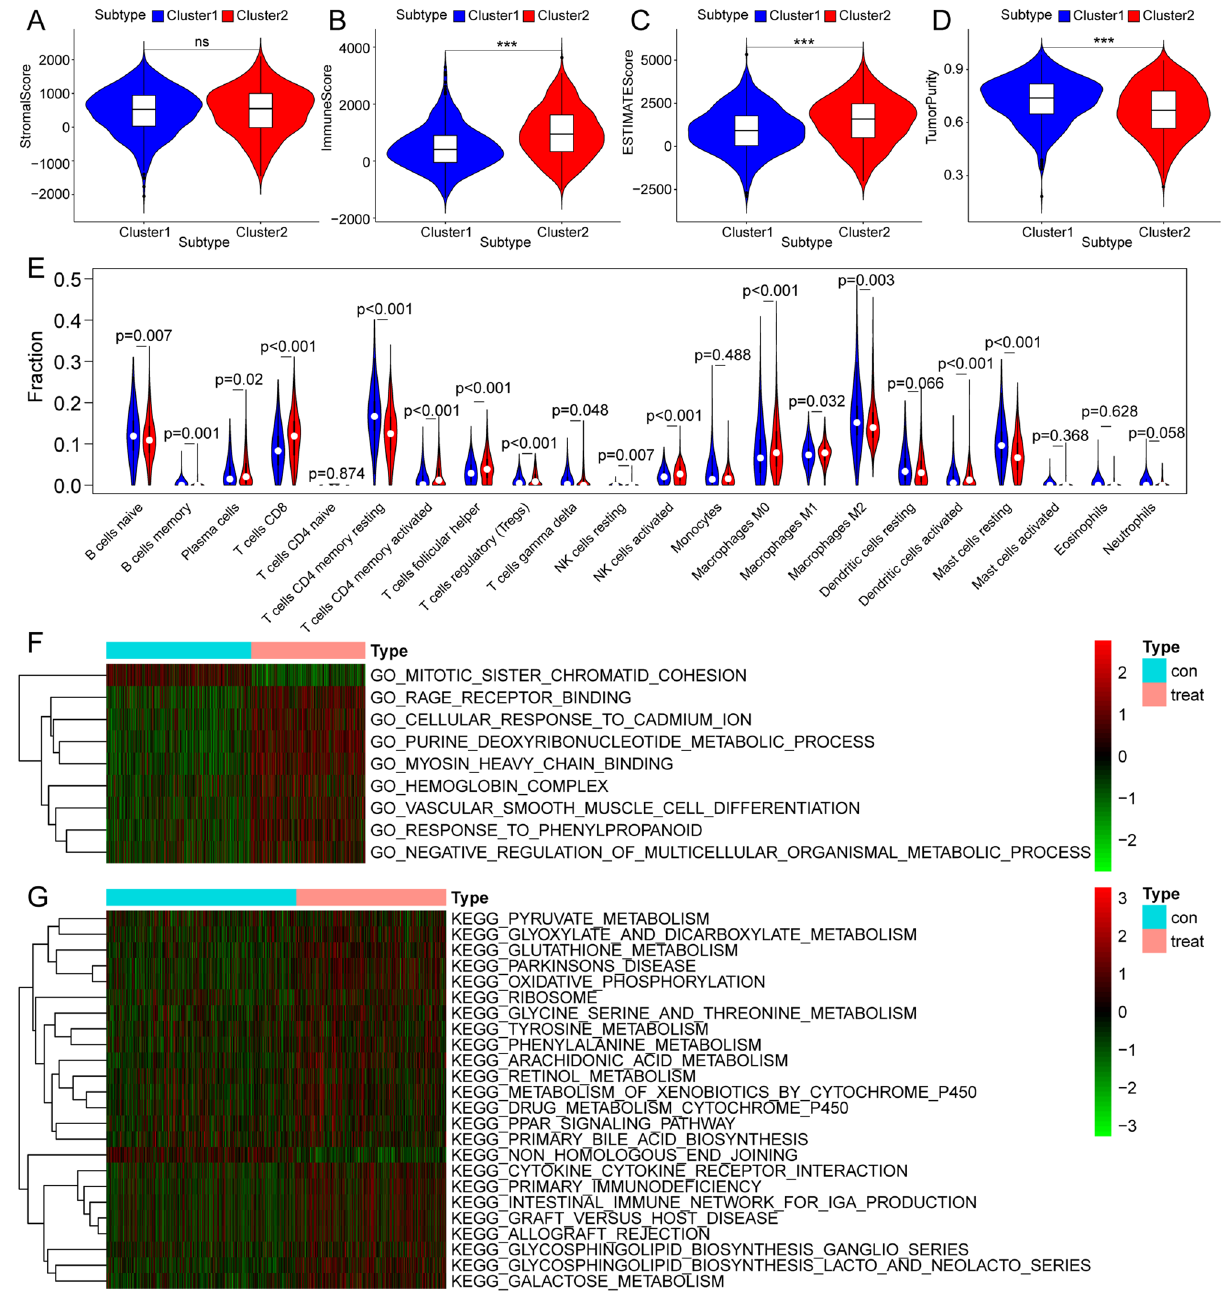
Figure 3. Analysis of tumour microenvironment, immune cell infiltration, and GSVA among different tumour classification. Blue is cluster 1 and red is cluster 2. ( A – D ) The relationship between tumour classification and tumour microenvironment. ( E ) The relationship between tumour classification and immune cell infiltration. ( F , G ) The relationship between tumour classification and GSVA enrichment. ( F ) Gene ontology analysis. ( G ) Kyoto Encyclopedia of Genes and Genomes pathway enrichment